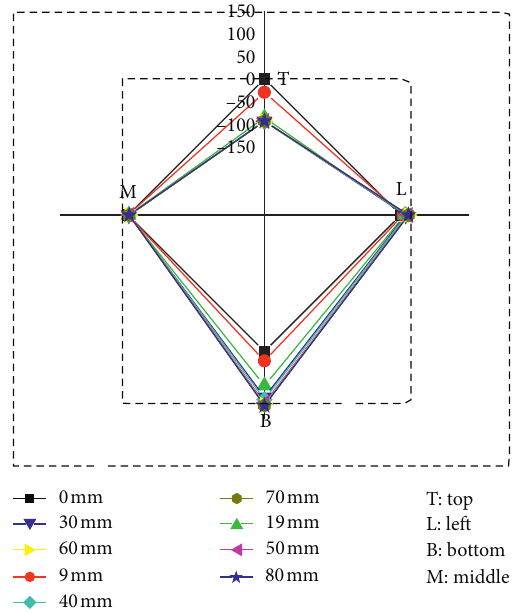
Figure 19: Hanging wall cross-sectional cabin 2 displacement.